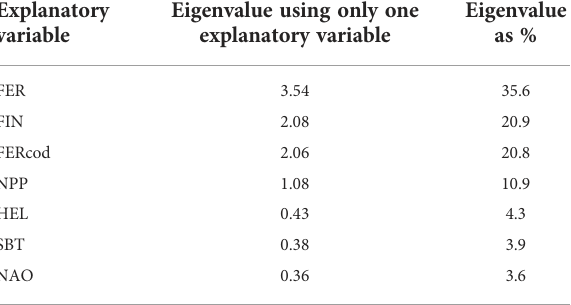
TABLE 1 Marginal effects of the explanatory